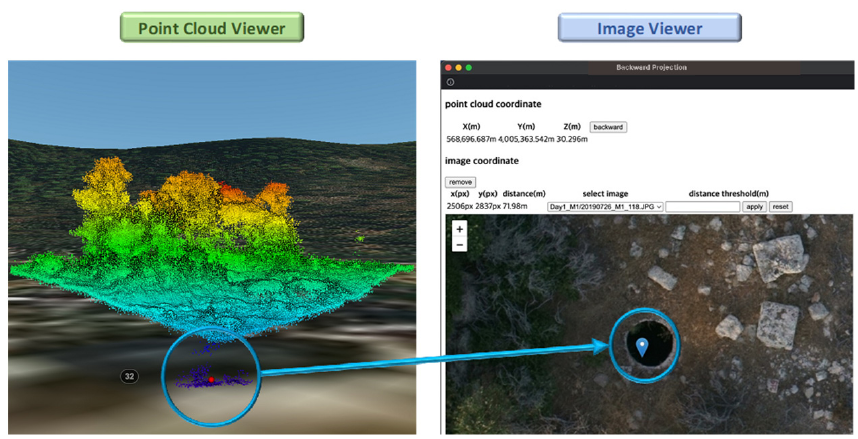
Figure 27. Illustration of the backward projection of a selected cistern location (red dot) in the LiDAR point cloud and corresponding image where it is visible (blue placemark).